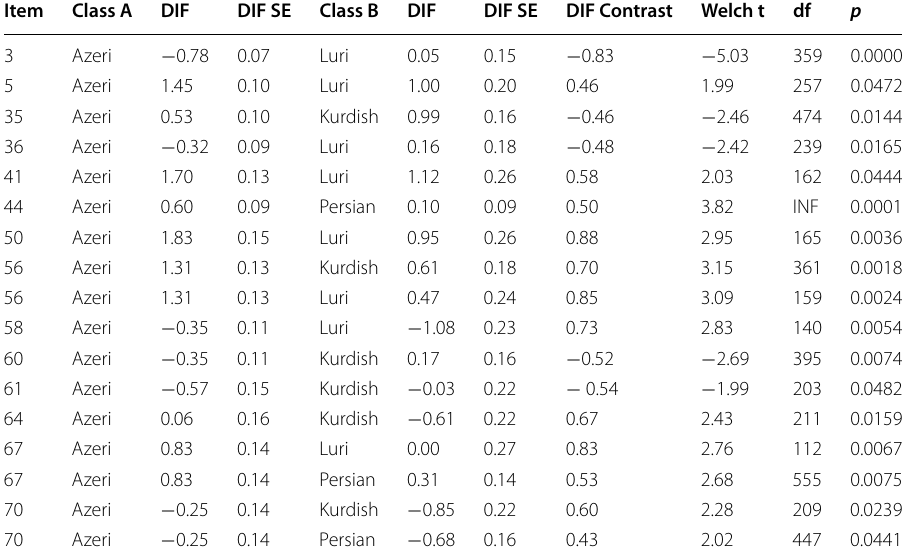
Table 9 Results of uniform DIF analysis of items (IUUESEE 2018) Item